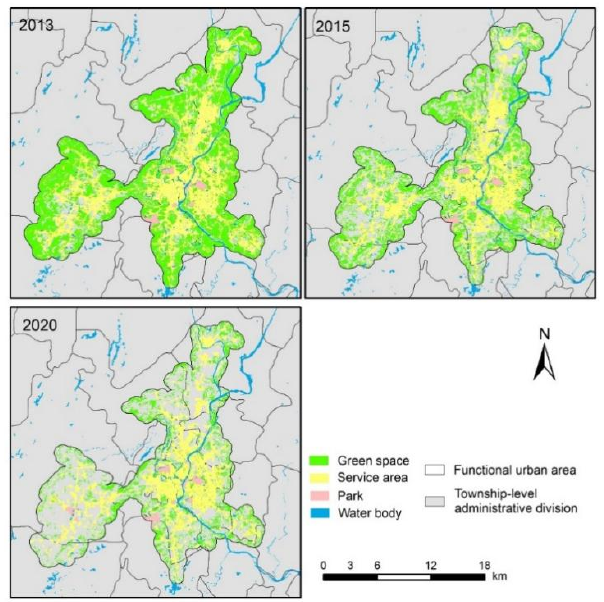
Figure 9. Open public spaces and service areas from 2013 to 2020 in Guilin. Table 5. Population with access to open public spaces from 2013 to 2020 in Guilin.